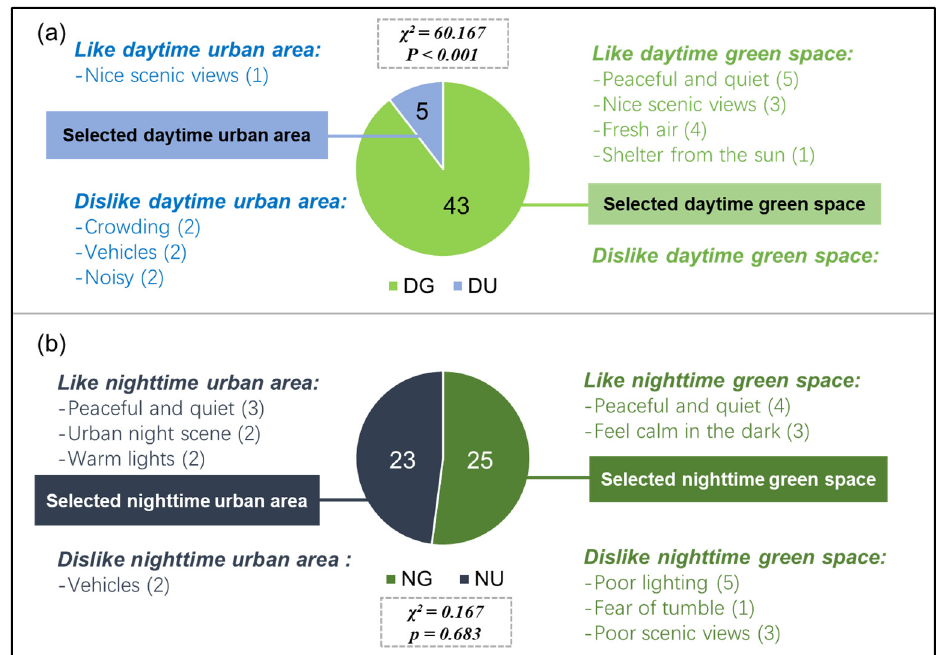
Figure 11. Preferences of participants towards different walking environments. The ( a ) and ( b ) represent daytime walking environments and nighttime walking environments respectively. The DG, NG, DU, and NU represent daytime green space, nighttime green space, daytime urban area, and nighttime urban area, respectively. Analyzed using Chi square test ( N = 48).